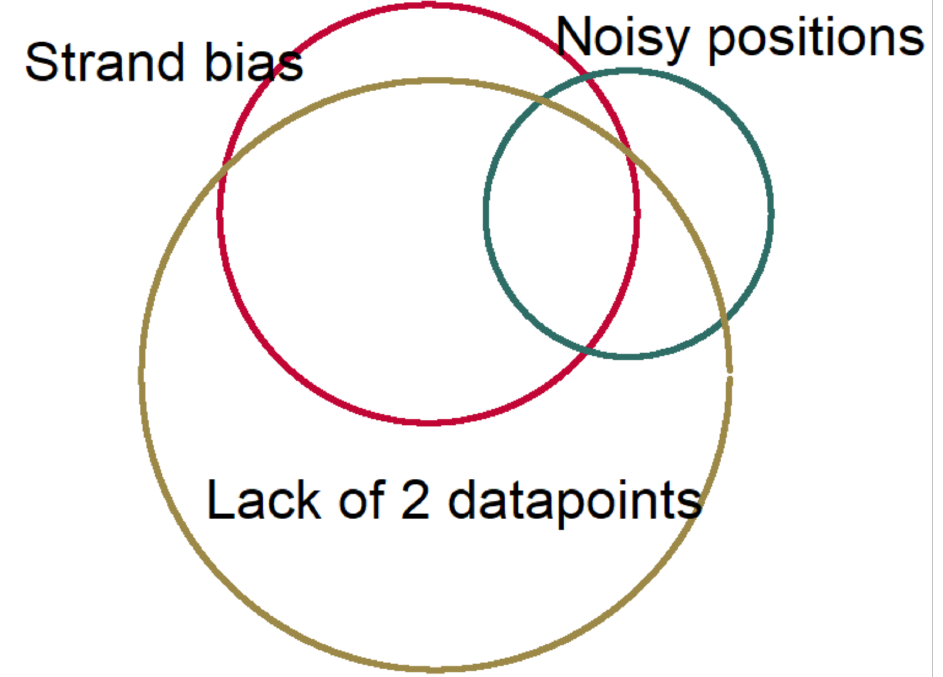
Figure 5. The relative proportion of losing data in each filtering